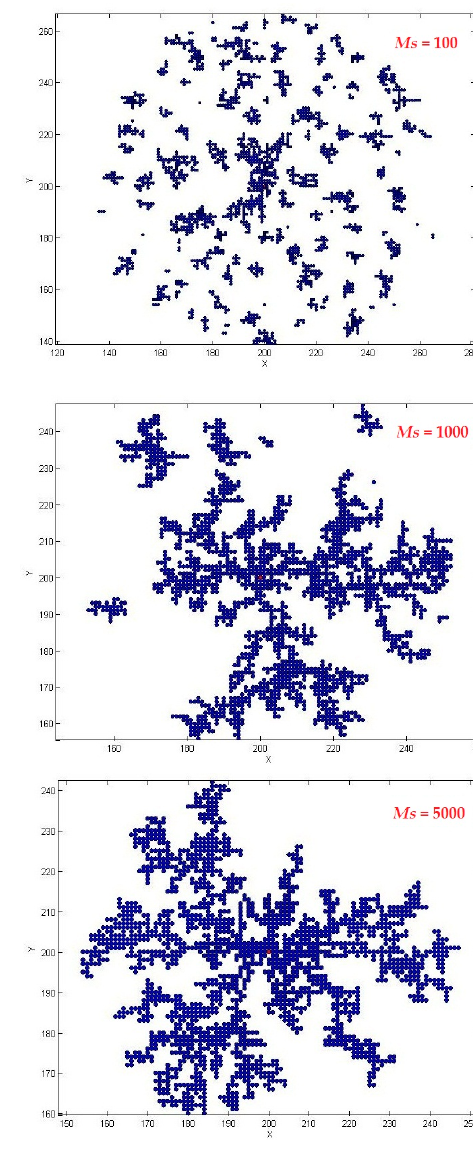
Figure 12. 3D DLA aggregates with diverse finite motion step numbers.